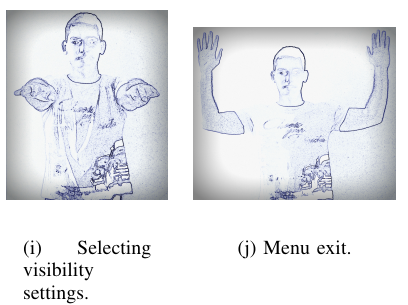
Fig. 11: In (a), (b), (c), (d), (e), (f) and (g), hand gestures to control 2D images.